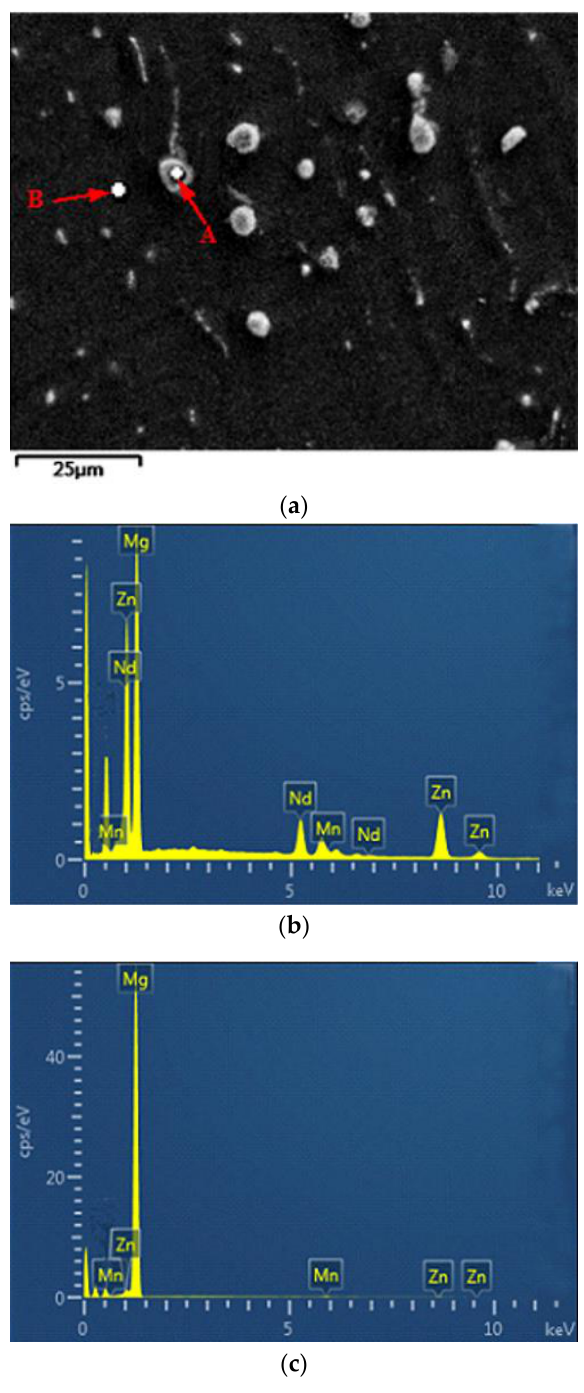
Figure 4. ( a ) SEM micrograph of the extruded3 alloy, ( b ) EDS analysis corresponding to assigned A area and ( c ) EDS analysis corresponding to assigned B area.